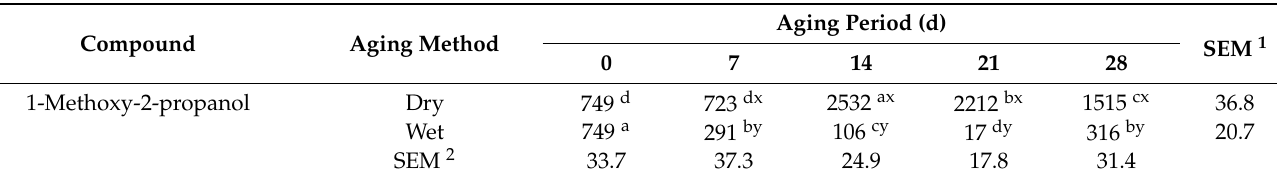
Table 6. Peak area of alcohols in beef during aging with different aging